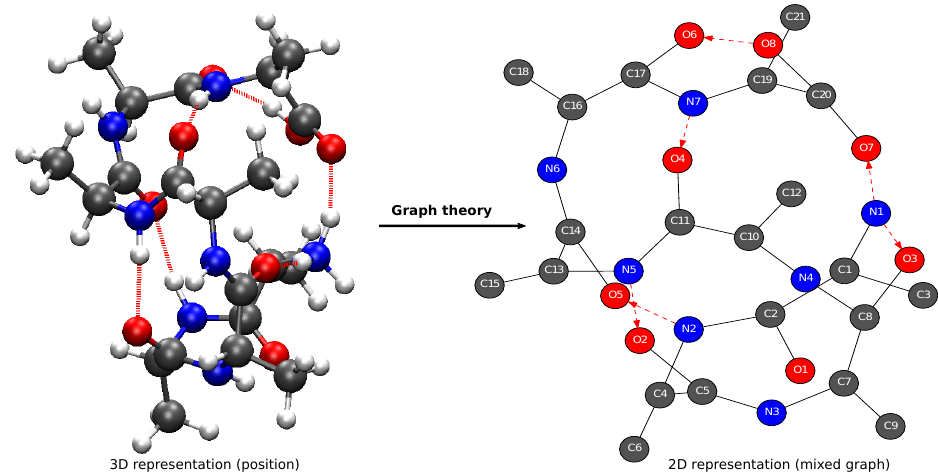
Figure 1. One snapshot (3D representation, ( left )) and its associated 2D MolGraph ( right ) from a − Ala − COOH (C trajectory of NH + 7 21 H 38 N 7 O 8 ) peptide in the gas phase. In the left panel, carbon 3 atoms are represented in dark gray, nitrogen atoms in blue, oxygen atoms in red, and hydrogen atoms in light gray. In the 2D MolGraph ( right ), the conventions are the following: vertices are colored in dark gray, blue, red and light gray, corresponding respectively to a carbon atom, nitrogen atom, oxygen atom and hydrogen atom; the edges are colored and represented in black lines when a covalent bond exists between two atoms (i.e., between two vertices) and in red dashed lines when a hydrogen bond exists between a heavy atom and the H-bond acceptor (i.e., between the associated vertices), which is an arc as seen by the arrow going from donor to acceptor of the